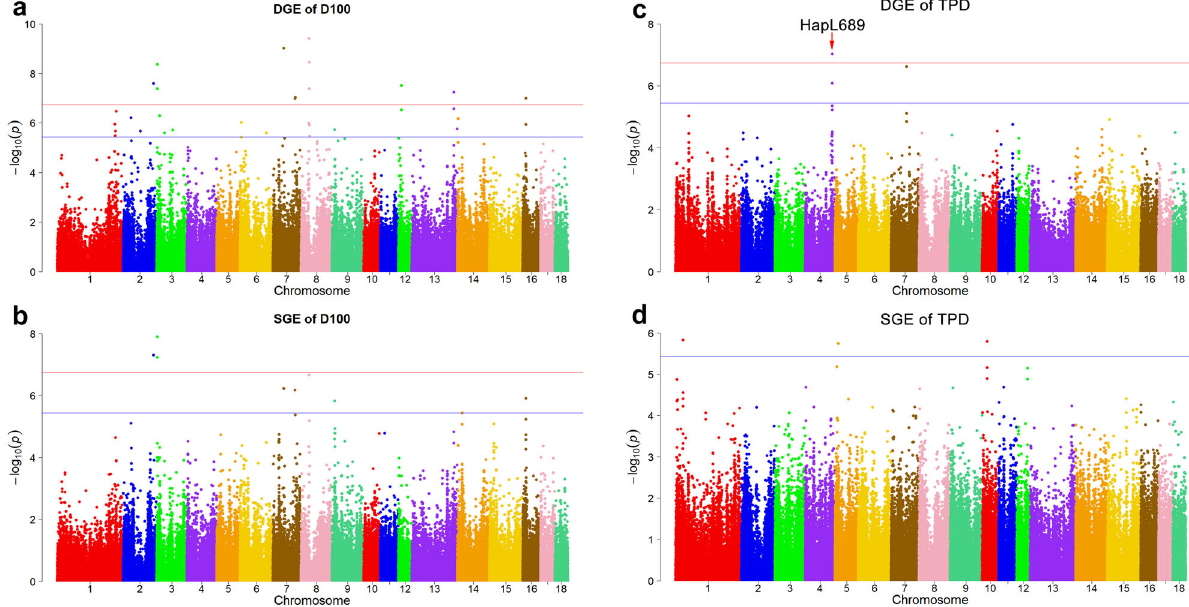
Fig. 6 Haplotype-based GWAS results for direct genetic effects (DGE) and social genetic effects (SGE). a for DGE in days to 100 kg (D100); b for SGE in D100; c for DGE of the time in feeder per day (TPD); d for SGE of TPD. The horizontal red and blue lines indicate the genome-wide (1.82 × 10 − 7 ) and suggestive (3.64 × 10 − 6 ) level, (HapL36 HapL1601, and HapL213) were detected for DGE and SGE. Eighteen candidate genes were located within these sig- ni fi cant regions. The SDK1 gene within the signi fi cant haplotype HapL36 was shared by DGE and SGE. On basis of the suggestive level ( P ¼ 3 : 64 ´ 10 (cid:1) 6 ), a total of 21 haplotype loci were detected for DGE and 13 for SGE (Supplementary Table 4). For B100, no haplotype loci were found to be associated with DGE (Supple- mentary Fig. 5a) or SGE (Supplementary Fig. 5b).